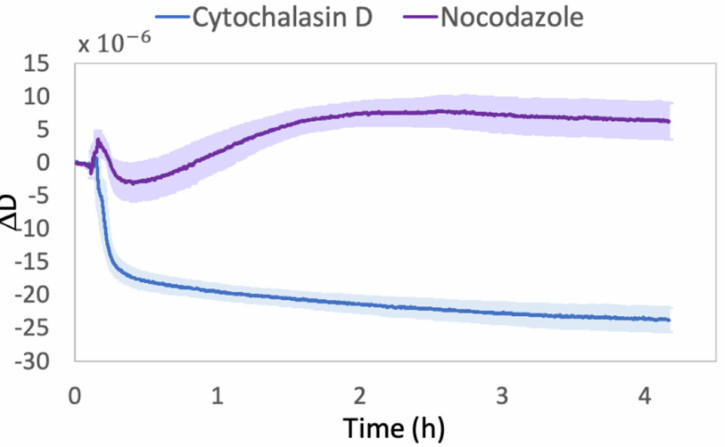
Figure 2. Comparison between dissipation shifts ( ∆ D) of Cyt-D- and Noc-treated cells. The mean values are relative to three independent replicas performed with different sets of cells. The reported ∆ D values are relative to D signals recorded from 10 min before the drug solution injection (5 µ M Cyt-D or 10 µ M Noc) until the end of four hours of